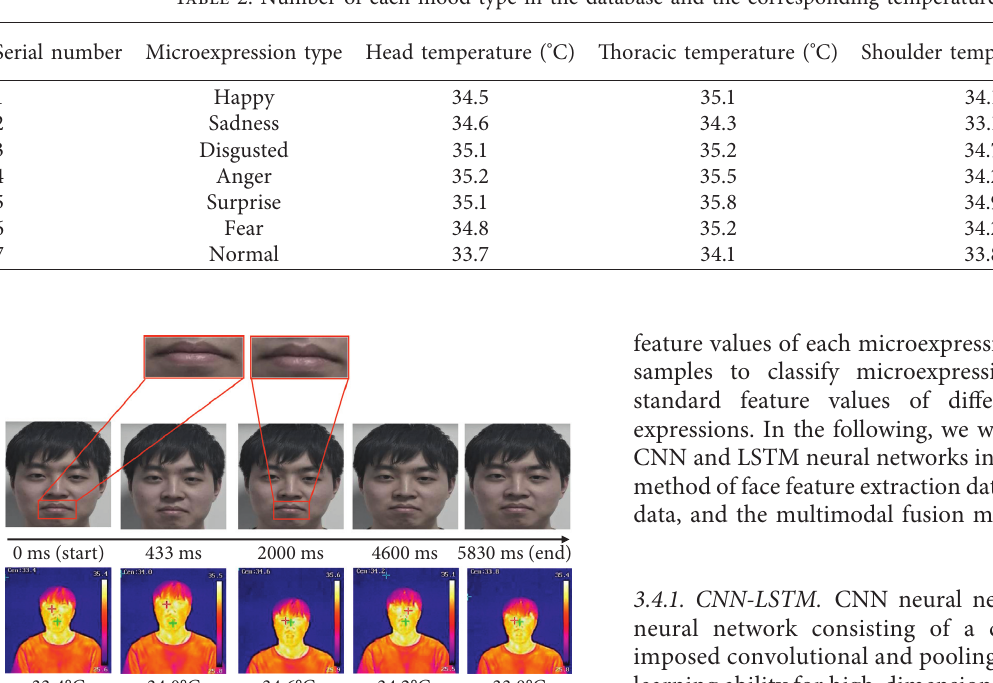
Table 2: Number of each mood type in the database and the corresponding temperature data.